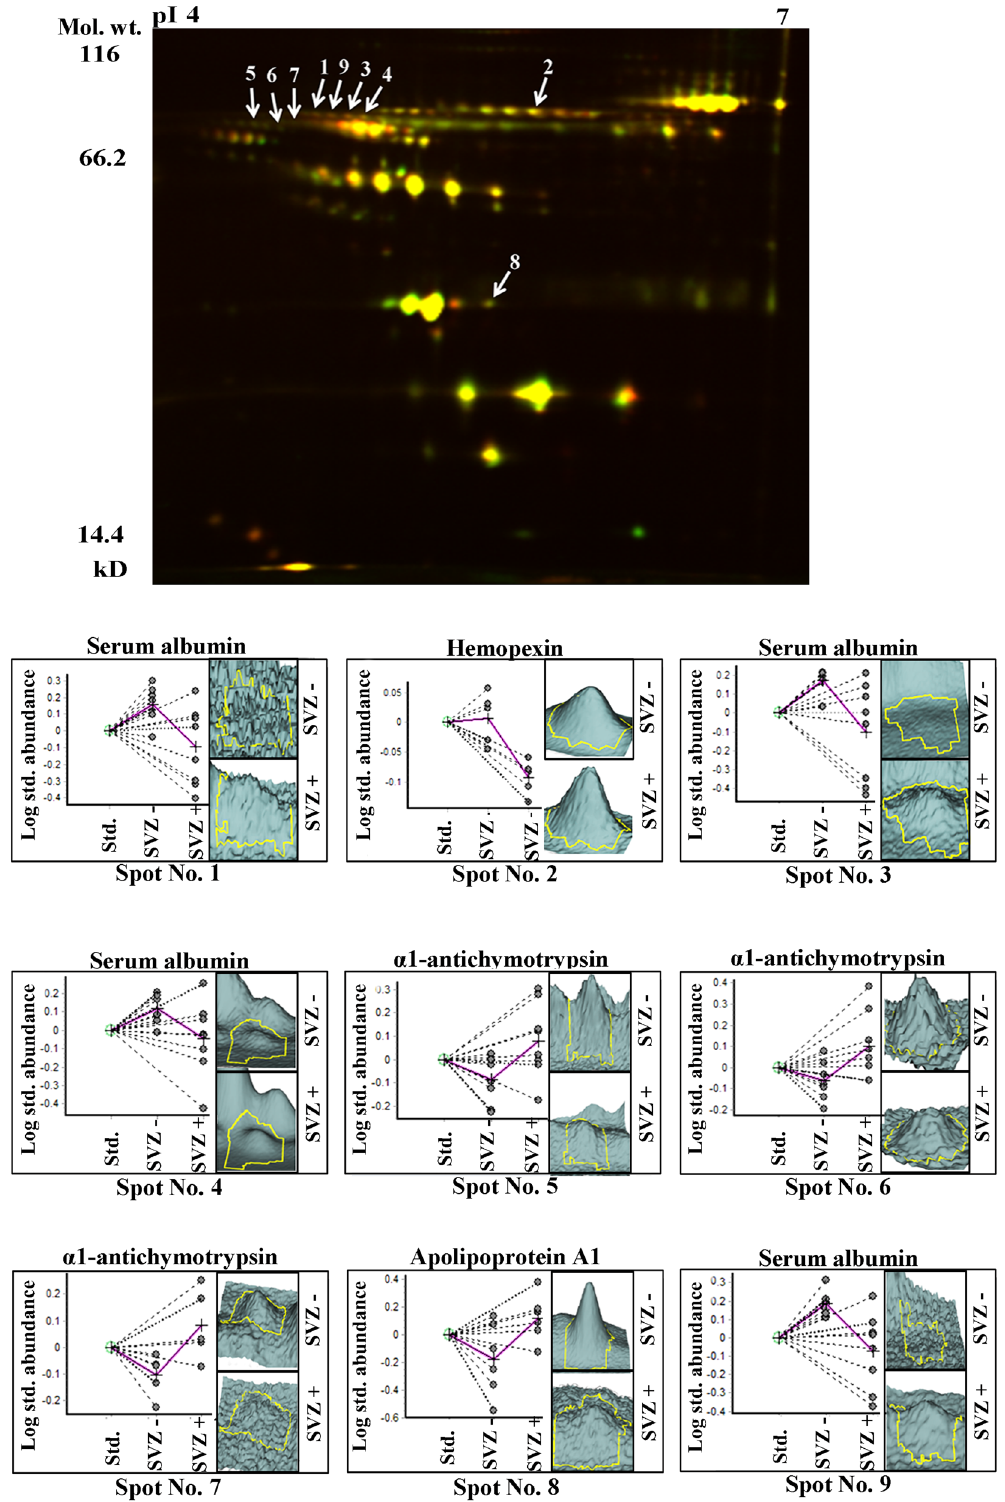
Figure 1. Representative overlapped 2D-DIGE gel image of SVZ + and SVZ − GBM patient’s serum proteome and 3D-views of significantly altered proteins. Extracted serum proteome from SVZ + (n = 8) and SVZ − (n = 8) GBM patients were labeled with respective CyDyes and separated on IPG strips of pH 4–7; 18 cm followed by separation on 12.5% SDS polyacrylamide gels. 2D-DIGE analysis was performed using DeCyder 2D software version 7.0 and the identities of significantly altered protein spots were established using MALDI-TOF/TOF analysis (Green colour indicates Cy3 labeled protein and red colour indicates Cy5 labeled